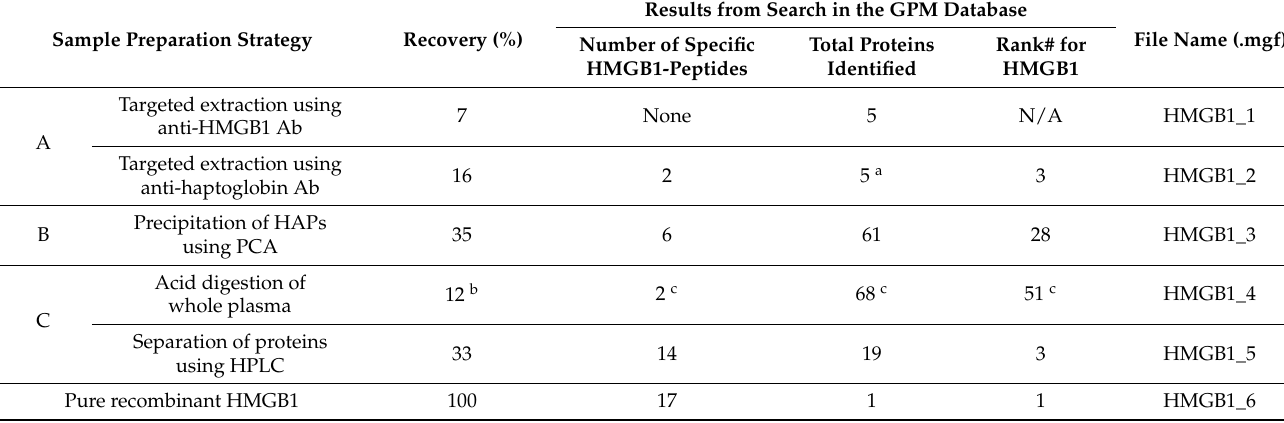
Table 1. Outcomes of different sample preparation strategies for measuring high mobility group 1 (HMGB1) protein in human plasma. Recovery was calculated by comparing the peak area response from the extracted ion chromatogram for the IKGEHPGLSIGDVAK peptide in processed samples along with the response in samples with pure recombinant HMGB1. The number of peptides and other proteins identified was found by searching the Global Proteome Machine (GPM) database [28,29]. Data files in the mascot generic format (MGF) can be downloaded from a data repository online [30].